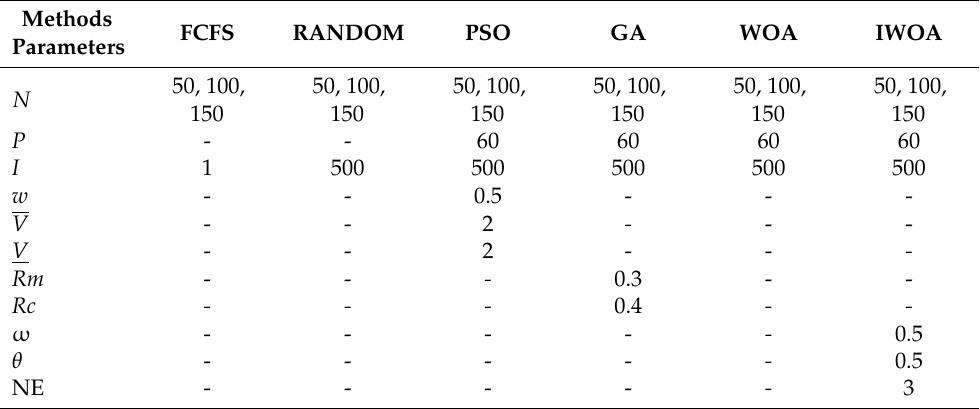
Table 1. The parameter setting for different